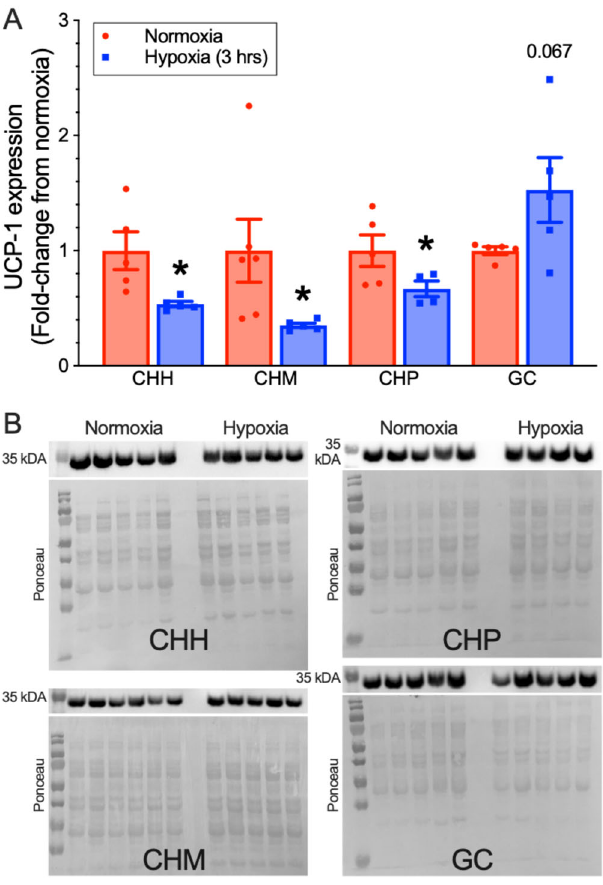
Fig. 9 Acute hypoxia reduces uncoupling protein 1 (UCP1) expression in interscapular brown adipose tissue (iBAT) from social, but not solitary species of African mole-rats. A Summary of western blot analysis of UCP1 protein expression in interscapular BAT homogenates from 4 species of African mole-rats related to naked mole-rats (CHH: Cryptomys hottentotus hottentotus , CHM: Cryptomys hottentotus mahali , CHP: Cryptomys hottentotus pretoriae , GC: Georychus capensis ) treated in 28 °C in normoxia (18% O bars; n = 6 biologically independent samples for CHM and 5 for other species) or after 3 h of hypoxia (5% O 2 , blue bars; n = 4 biologically independent samples for CHP and 5 for other species). Data are mean ± SEM. Asterisks indicate signi fi cant difference from normoxic controls (Welch ’ s one-sided t -test; CHH: t (4) = 2.818, p = 0.0228, CHM: t (5) = 2.361, p = 0.0321, CHP: t (6) = 2.181, p = 0.0369, GC: t (4) = 1.858, p = 0.0674). B Western blot images of UCP1 protein expression from ( A ), and total protein gel expression quanti fi ed with Ponceau S. Source data are provided as a Source Data fi